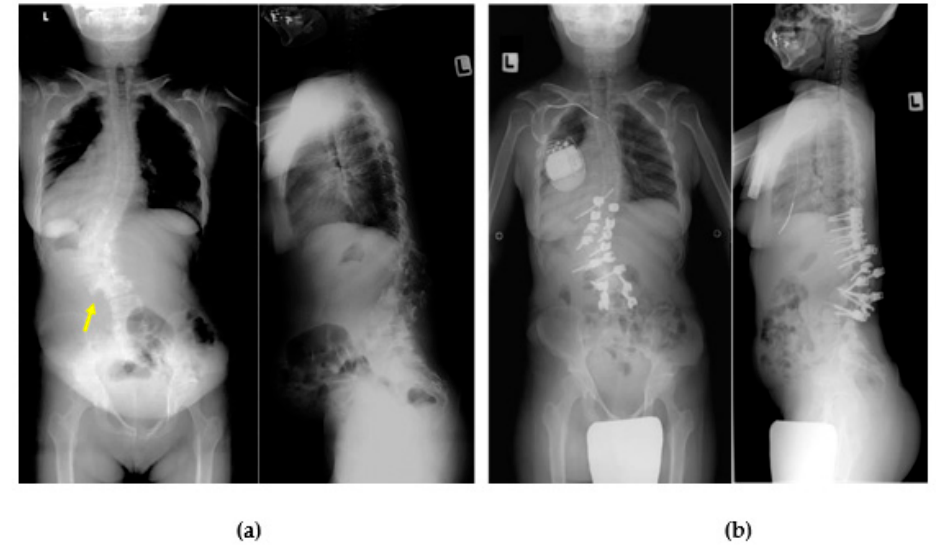
Figure 8. Thoracolumbar kyphosis in attenuated MPS I. X-ray images of a 31-year-old woman with MPS I with low-back pain showing kyphoscoliosis and lateral slip of the lumbar spine (arrow) ( a ). Cardiac arrest occurred during surgery in the prone position, which required discontinuing surgery just after completing the pedicle screw insertion. The patient recovered fully without critical damage, although she required a pacemaker ( b ). More than 10 years postoperatively, the degree of kyphoscoliosis and low-back pain had not